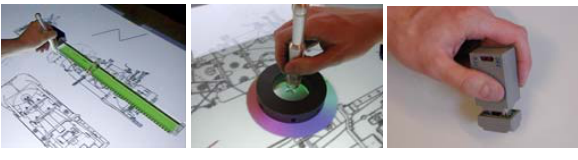
Figure 4. Different devices in the InterActables system For realizing these devices, also orientation and distance